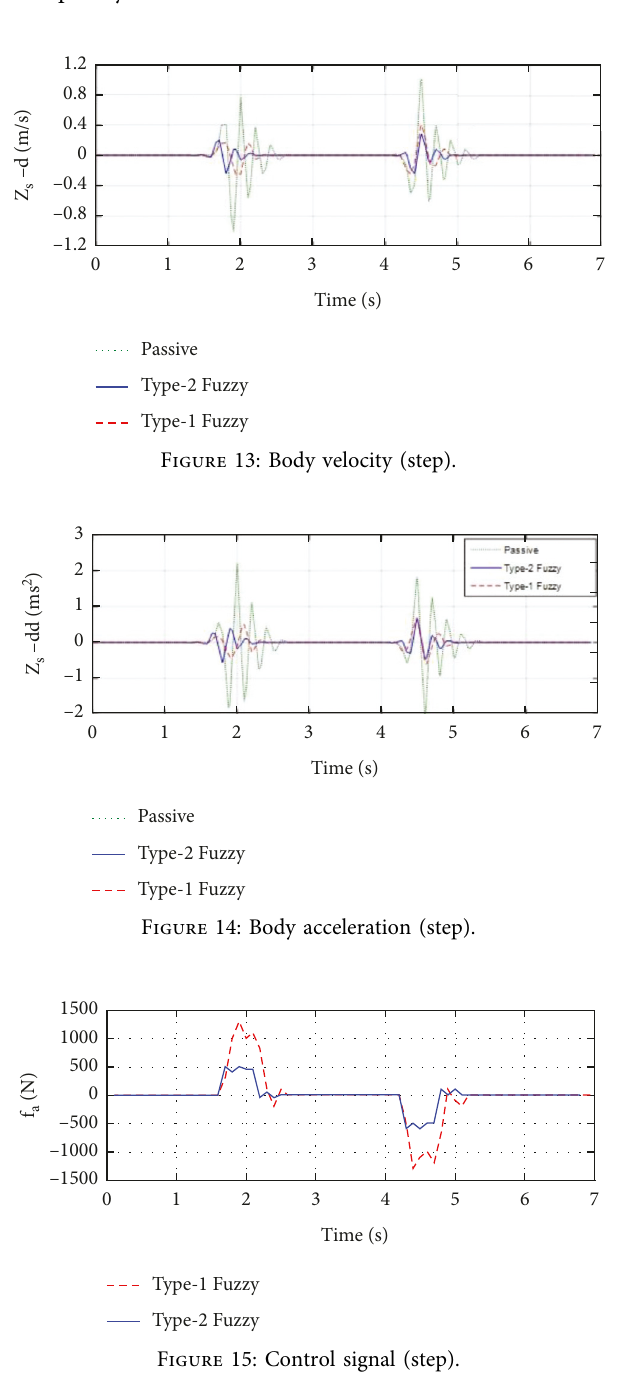
Figure 15: Control signal